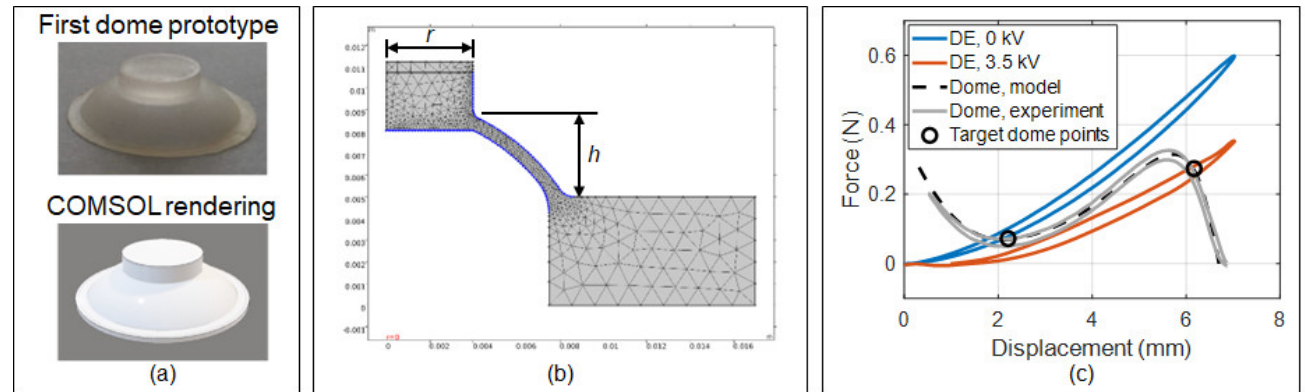
Figure 4. Single element polymeric dome bias, FE mesh ( a,b ), electro-mechanical simulation of single DEA system, experimental validation ( c ).